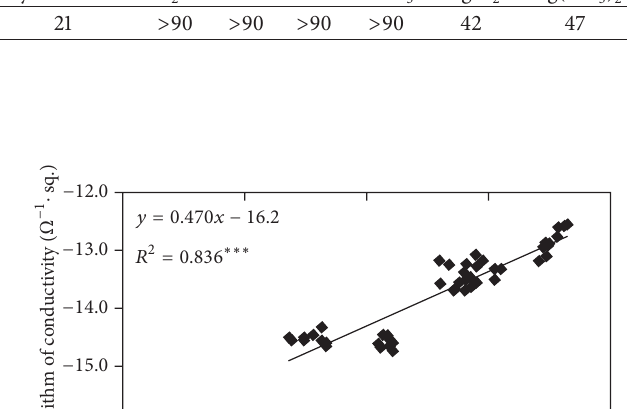
Table 2: Relative humidity in desiccators at 50 ∘ C filled with saturated solutions. Saturated solution Glycerin 5%